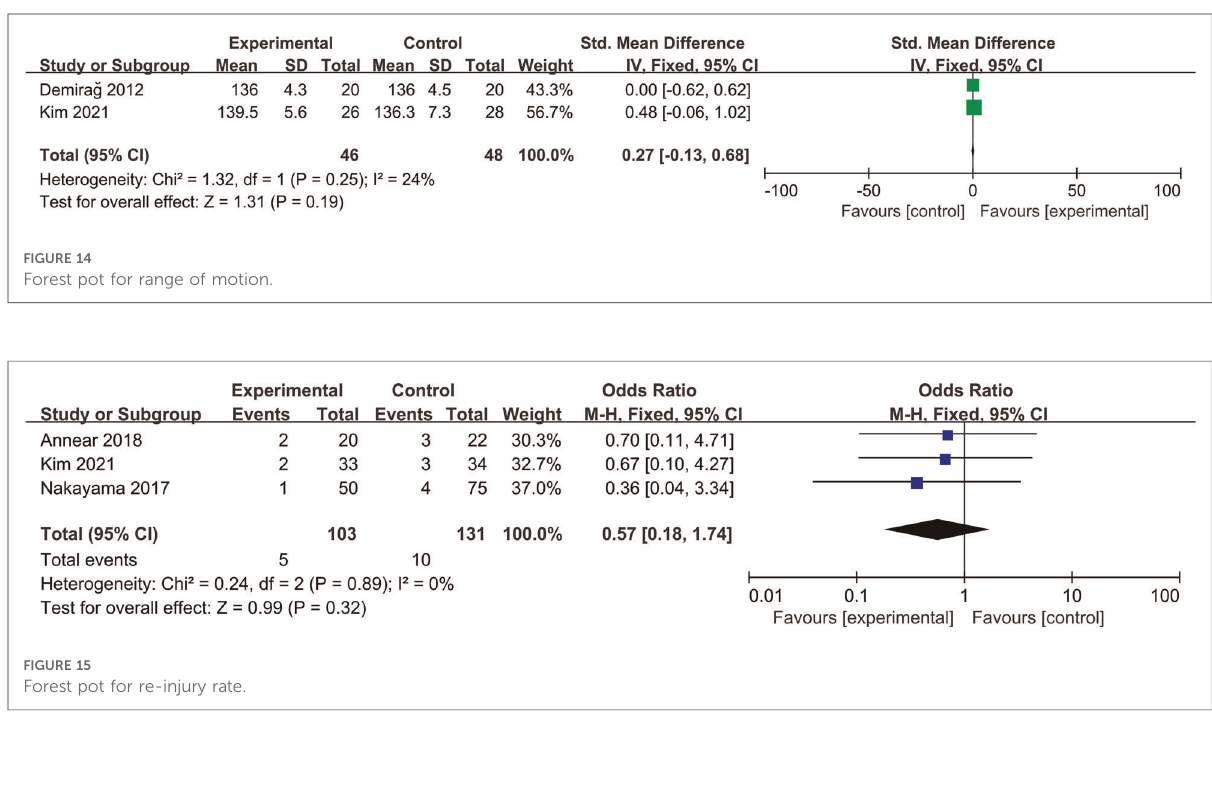
TABLE 2 Results of subgroup